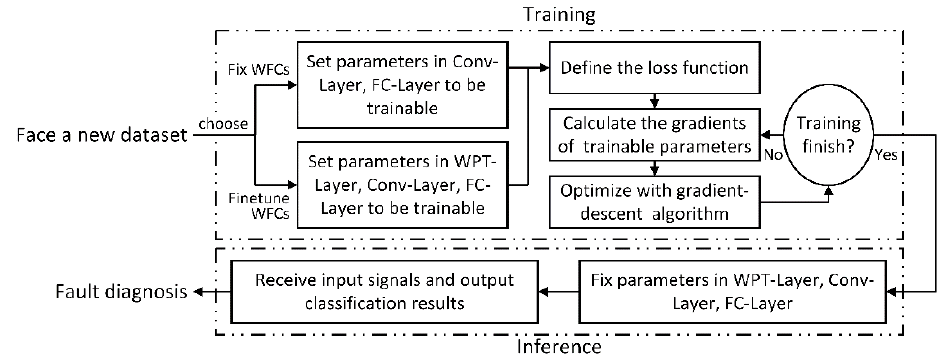
Figure 6. Flow chart for the training process of WPT-CNN.